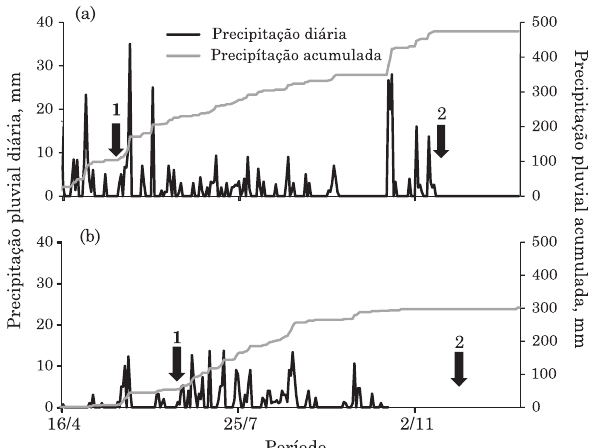
Figura 1. Precipitação pluvial diária e acumulada durante o cultivo de milho em 2011 (a) e em 2012 (b). Setas indicam época de plantio (1) e colheita